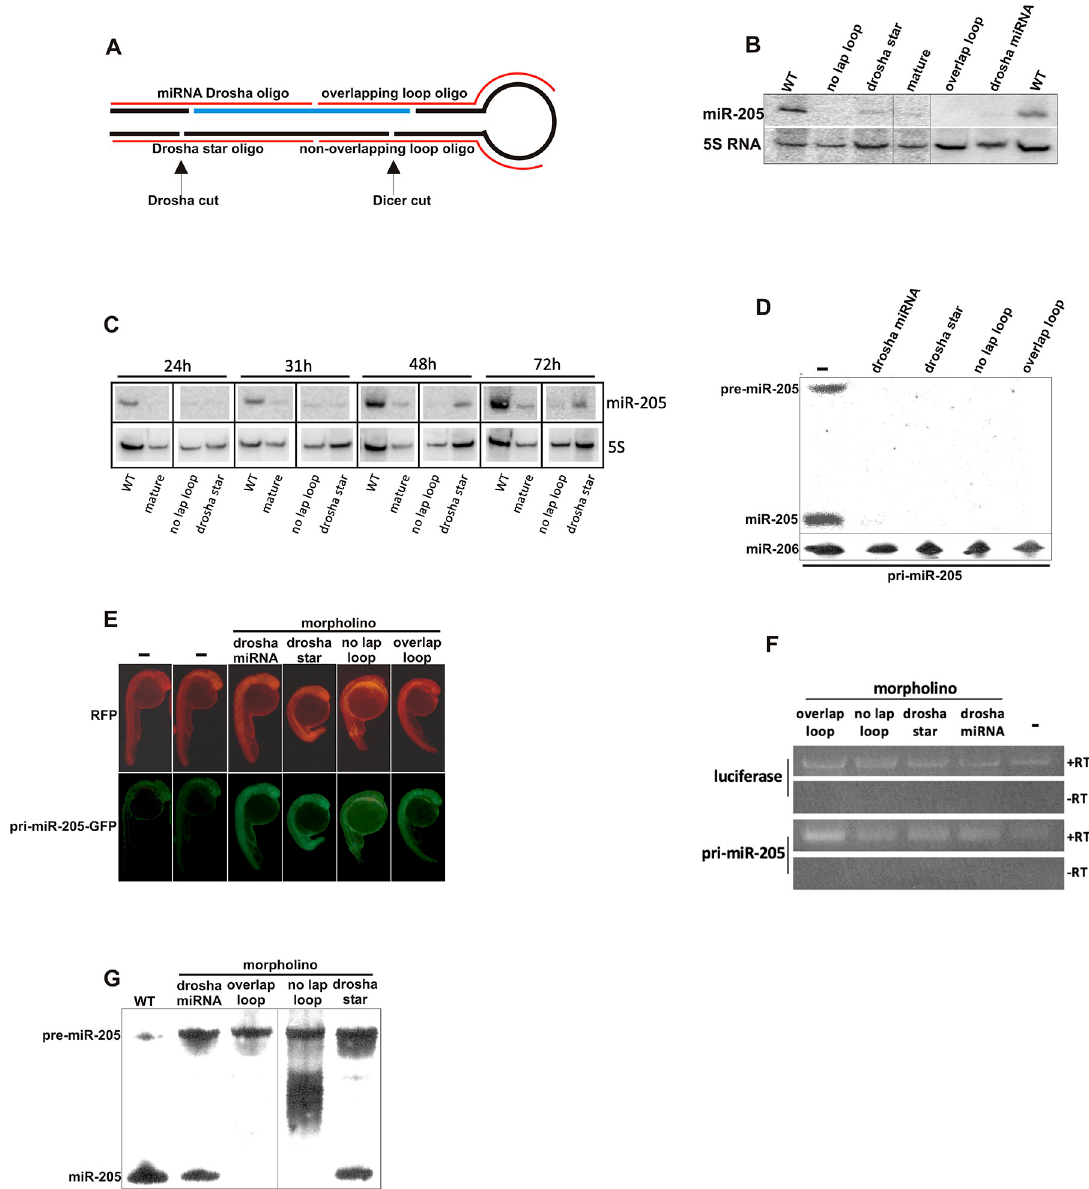
Fig 2. Morpholinos Targeting the Precursor miRNA Interfere with miRNA Maturation. (A) Design of morpholinos targeting the precursor miRNA. (B) Northern blot analysis of miR-205 in 30-h-old embryos injected with different morpholinos against pri-miR-205. 5S RNA serves as a loading control. (C) Time series of miR-205 expression after injection of mature, no lap loop, and drosha star morpholinos against pri-miR-205. (D) Northern blot analysis of miR-205 derived from embryos injected with a GFP-pri-miR-205 transcript and four different morpholinos targeting pri-miR-205. Co-injected miR-206 serves as an injection and loading control. Embryos were collected 8 h after injection. (E) GFP expression in 24-h embryos injected with morpholinos and a GFP-pri-miR-205 construct as used in (C). Pri-miR-205 is positioned just upstream of the polyA signal in the 3 0 UTR of the GFP mRNA. Red fluorescent protein (RFP) serves as an injection control. (F) RT-PCR analysis of injected GFP-pri-miR-205 mRNA with (+) and without ( − ) co- injected morpholinos. Luciferase serves as an injection control. Embryos were collected 8 h after injection. (G) Northern analysis of the effect of morpholinos on an injected miR-205 precursor. Embryos were collected 8 h after injection. WT, wild type.